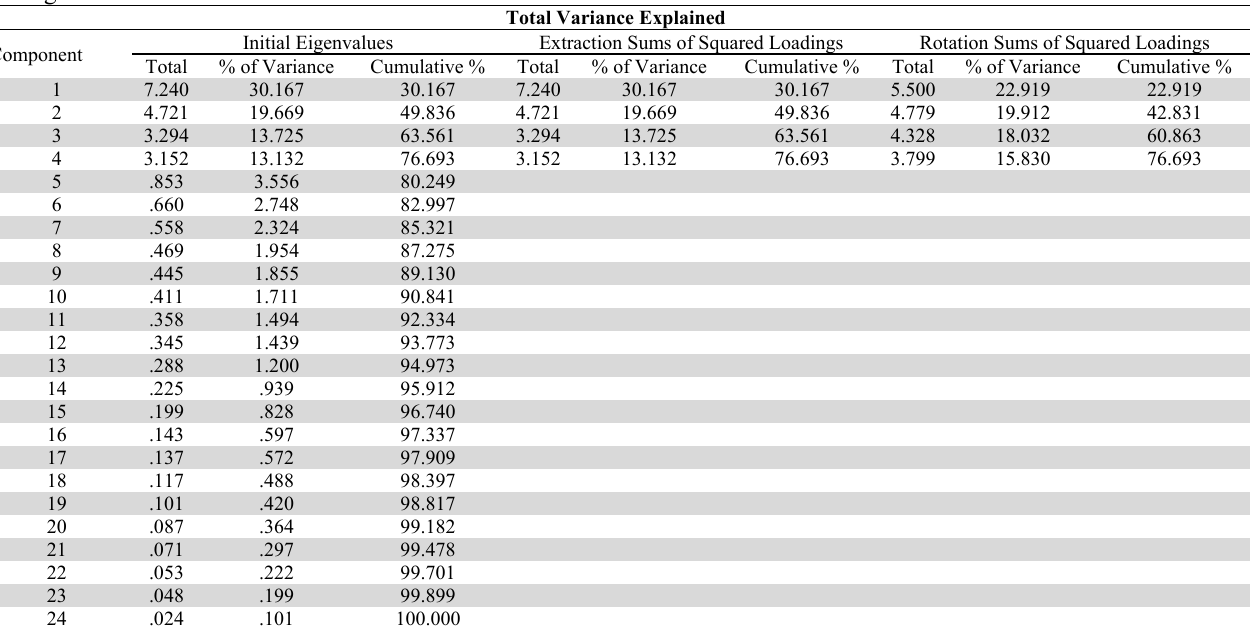
Testing variance extracted of factors